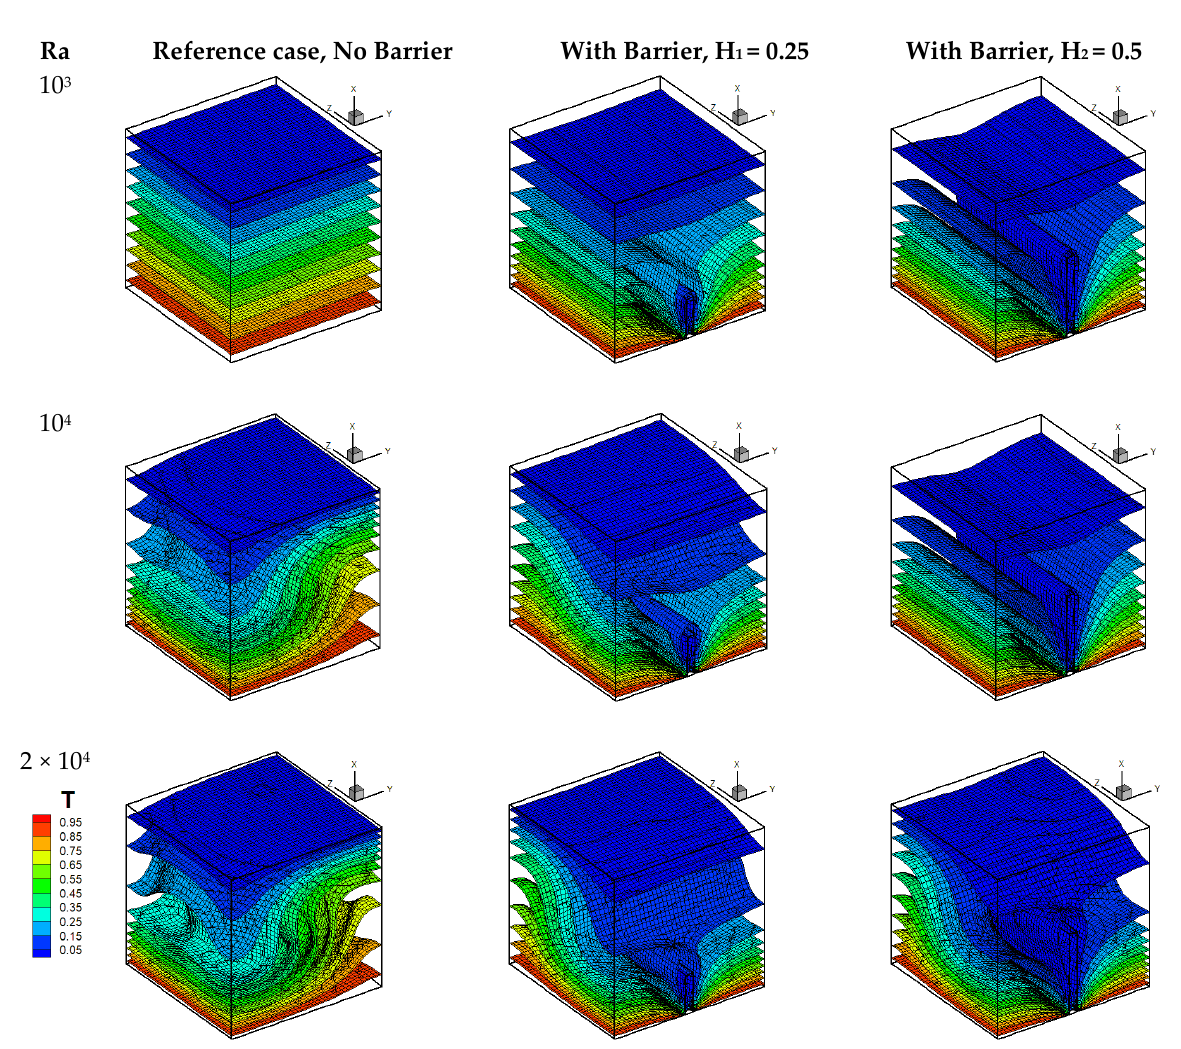
Figure 13. Temperature iso-surfaces in the building for different Ra , effect of two barriers’ heights for N = 0.2.